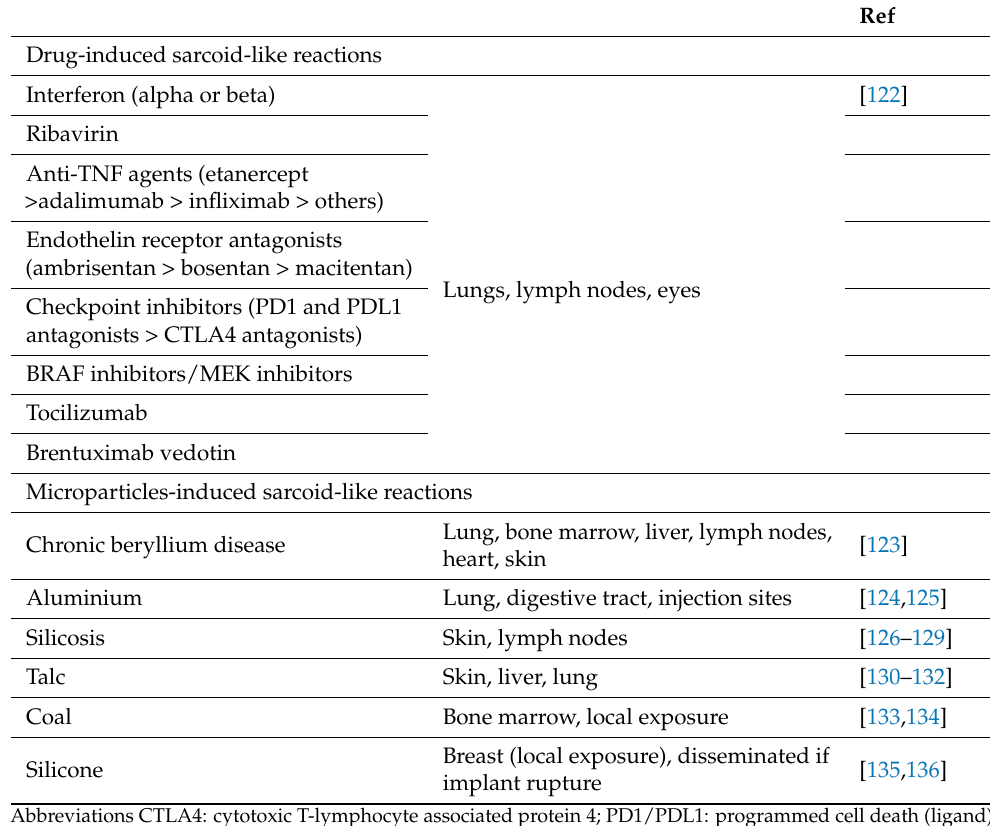
Drug and device or microparticles-induced sarcoid-like reactions and their main organ